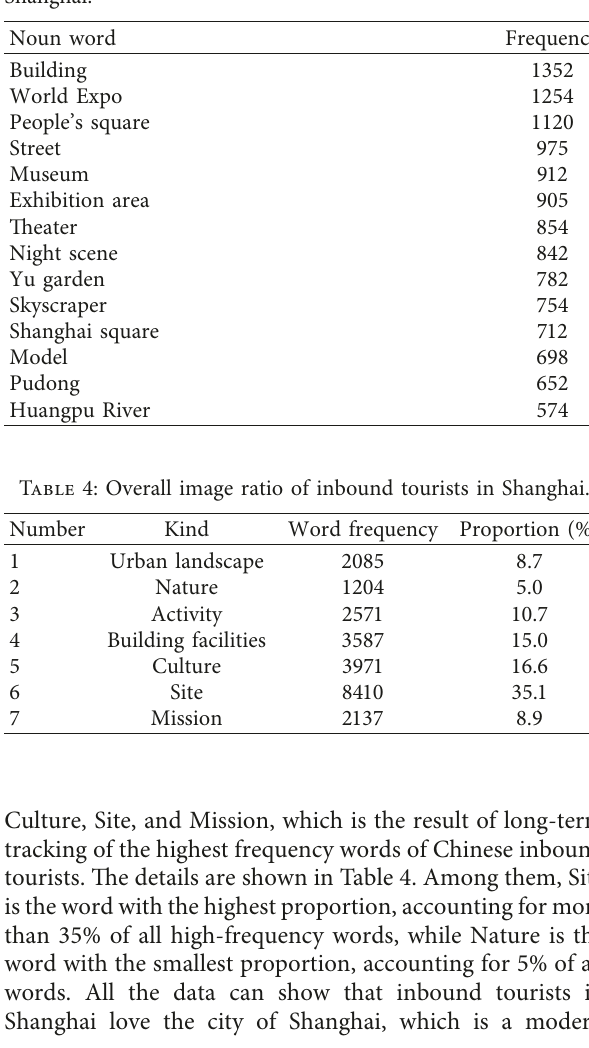
Figure 6: Proportion of inbound tourists in Shanghai from 2016 to Table 3: Overall cognitive image perception of inbound tourists in Shanghai.